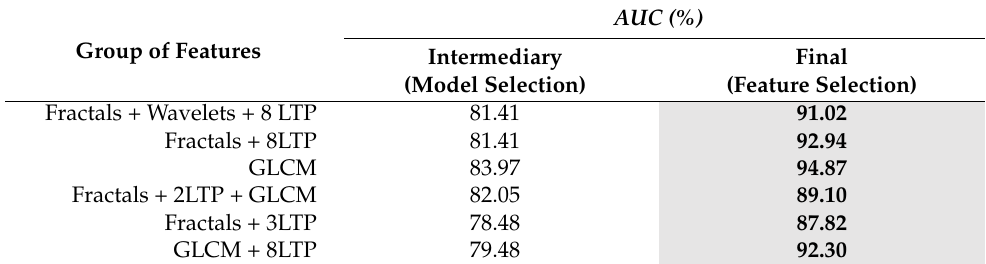
Table 7. AUC for Experiment 2: Results on model selection and on cancer detection.